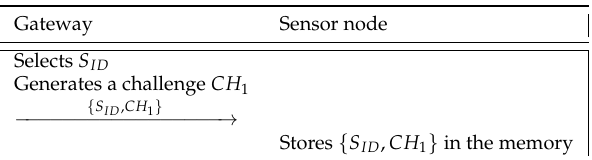
Figure 3. Initialization phase of the proposed